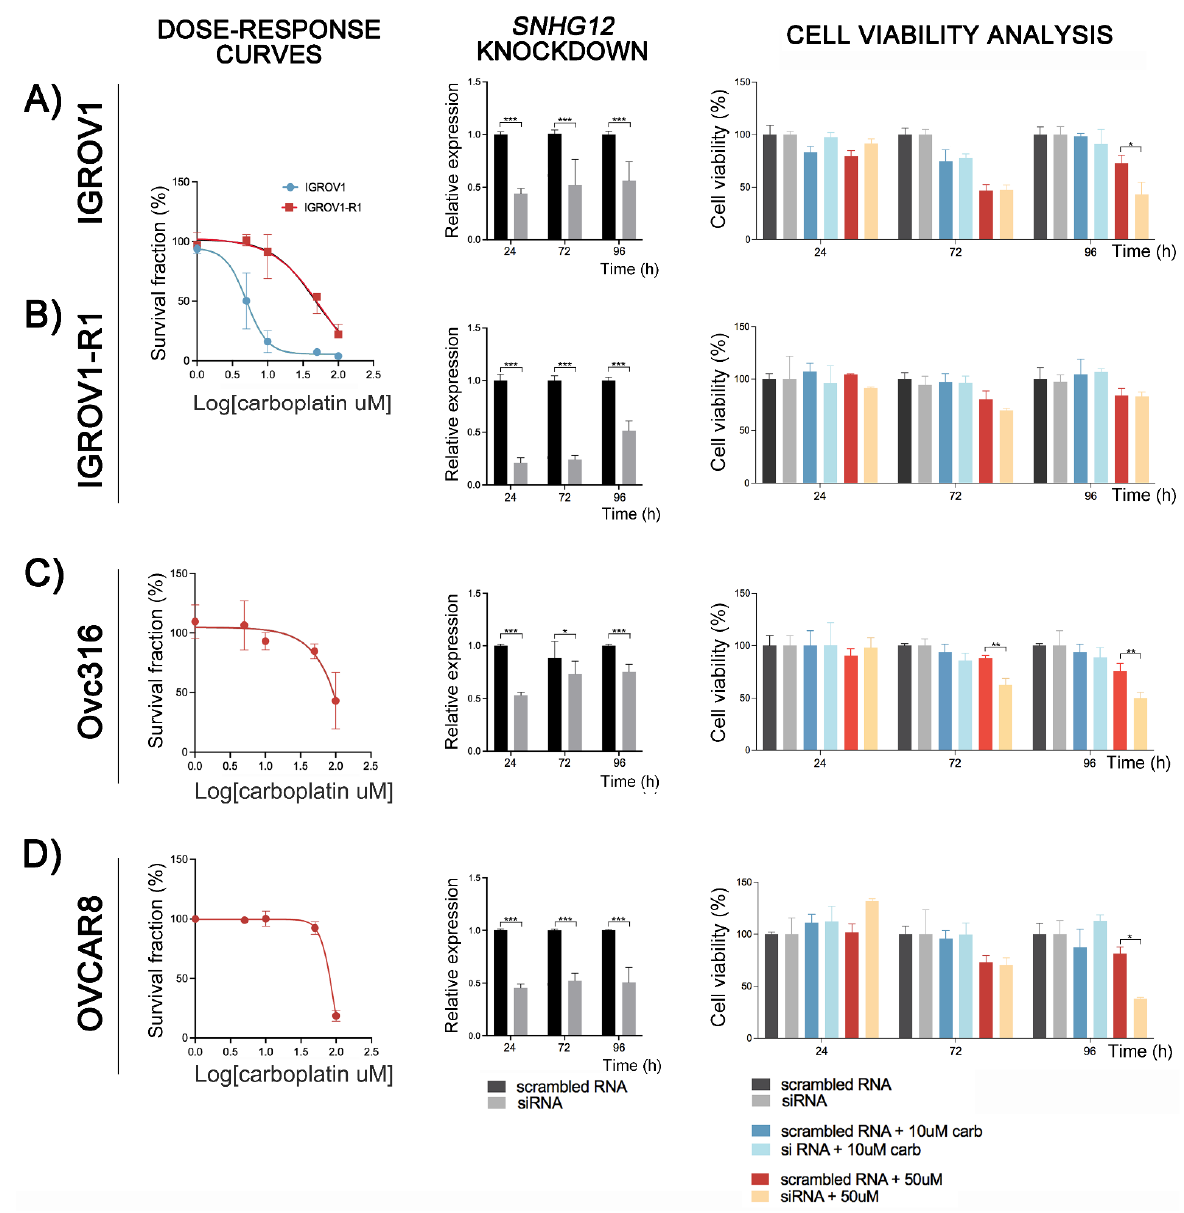
Figure 3. Effect of SNGH12 knockdown on the cell viability of ovarian cancer (OC) cell lines exposed to carboplatin. Dose-response curves of carboplatin treatment, the efficiency of the siRNA targeting the lncRNA SNHG12, and its effects on cell viability after carboplatin treatment are shown for the IGROV1 and its induced resistant-counterpart IGROV1-R1 ( A , B ), and in intrinsically resistant Ovc316 ( C ) and OVCAR8 ( D ), respectively. The cells were exposed to scrambled RNA or SNHG12 siRNA and treated with carboplatin (10 µM or 50 µM) during 24, 72 and 96 h. Cytotoxicity was determined by the CellTiter Blue Viability Assay. Knockdown led to a reduction of the relative expression levels of the lncRNA SNHG12 compared with the scrambled RNA after 24, 72 and 96 h in the IGROV1/IGROV1-R1 ( A,B ), Ovc316 ( C ), and OVCAR8 ( D) cells. (*) p < 0.05; (**) p < 0.001; (***) p < 0.0001.